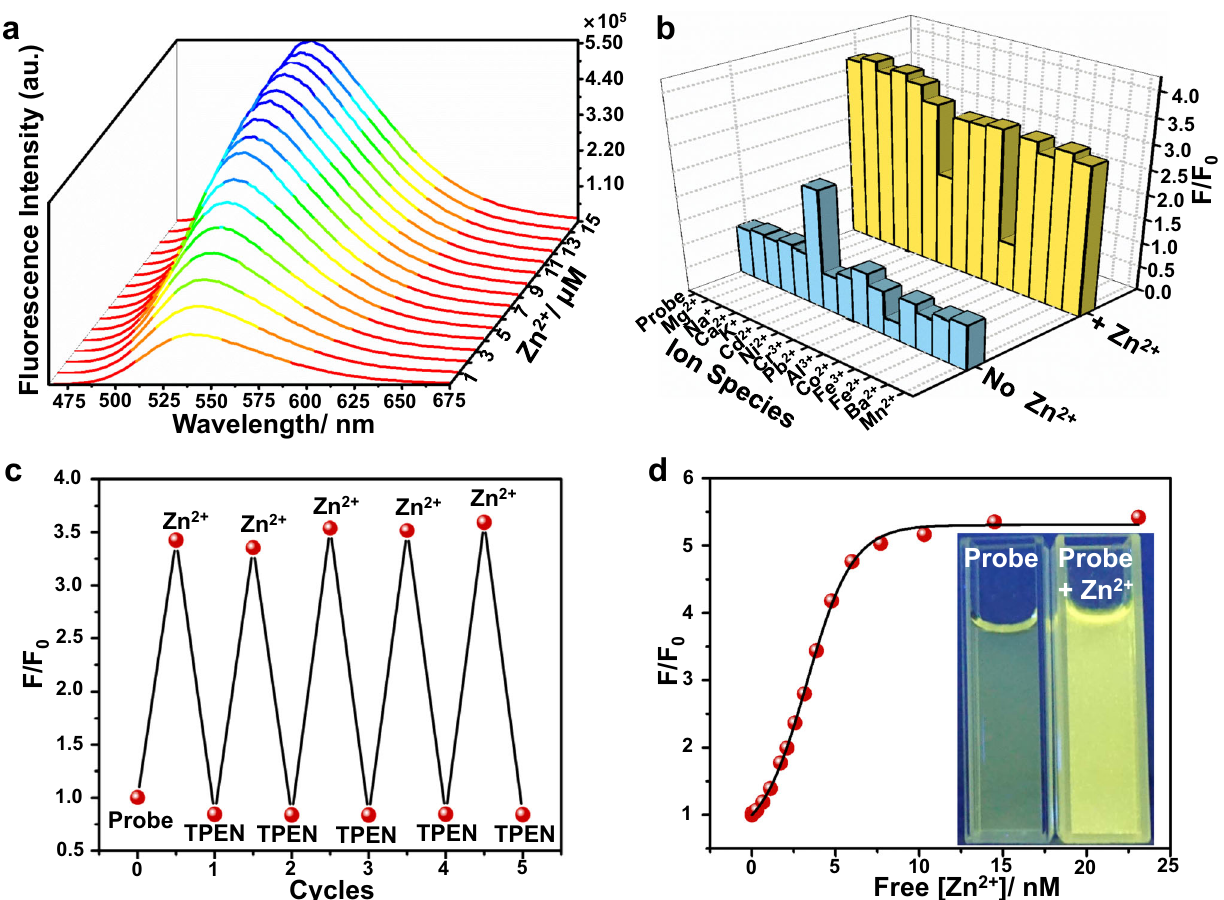
Fig. 2 NapBu-BPEA shows reversible Zn 2 + -speci fi c sensing behavior. Fluorescence spectroscopic determination of NapBu-BPEA (10 μ M) in HEPES buffer upon excitation at 450 nm. a Emission spectra determined upon Zn 2 + titration (10 mM, 0.3 μ L aliquot); b fl uorescence enhancement factor of NapBu-BPEA induced by K + , Na + , Ca 2 + , Mg 2 + (1000 eq), Cd 2 + , Ni 2 + , Cr 3 + , Pb 2 + , Al 3 + , Co 2 + , Fe 2 + , Fe 3 + , Ba 2 + , and Mn 2 + (1 eq), and the Zn 2 + (1 eq) induced enhancement factor in the presence of above cations. All are based on emission at 540 nm; c fl uorescent response of NapBu-BPEA based on emission at 540 nm in cycles of Zn 2 + (10 μ M) addition and subsequent TPEN (10 μ M) treatment; d fl uorescence of NapBu-BPEA at 540 nm determined in HEPES buffers containing different [Zn 2 + ] total for binding constant calculation. Inset in d : photograph of NapBu-BPEA solutions before and after Zn 2 + addition (1 eq) under UV lamp of 365